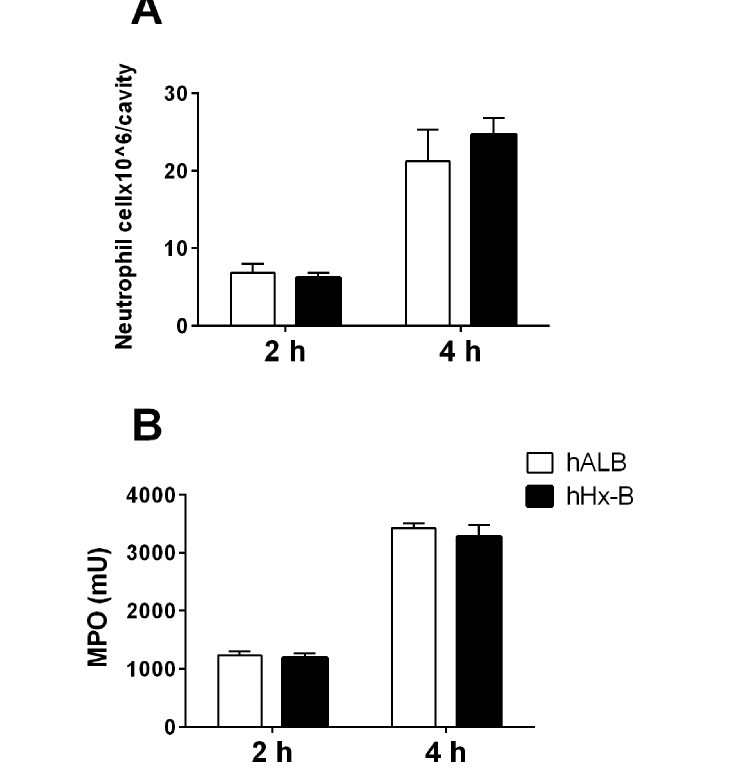
Figure 6. Hx does not suppress neutrophil migration in mice. Thirty minutes after intravenous injection of human Hx (hHx-B) or albumin (hALB) (2 mg/mouse), neu- trophil migration was induced by i.p. injection of 500 μ l of 4% thioglycolate. At 2 h or 4 h post injection, peritoneal cells were flushed out by PBS and counted. (A) The peritoneal cells were incubated with PE- conjugated anti-Gr-1 and analyzed via FACS to determine the percentage of neutrophils over the total cells. Total neutro- phils were calculated. (B) The MPO activity was measured in the total peritoneal cells. The results are representative of five independent experiments and presented as the mean ±